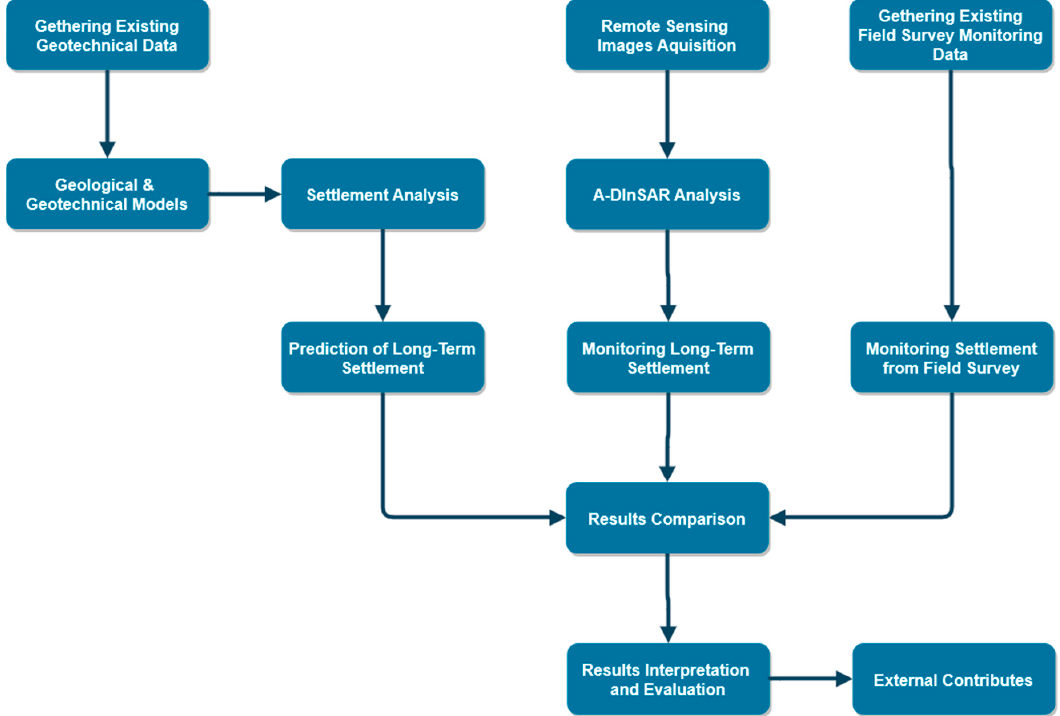
Figure 5 . Workflow of the approach adopted in the present work. Figure 5. Workflow of the approach adopted in the present